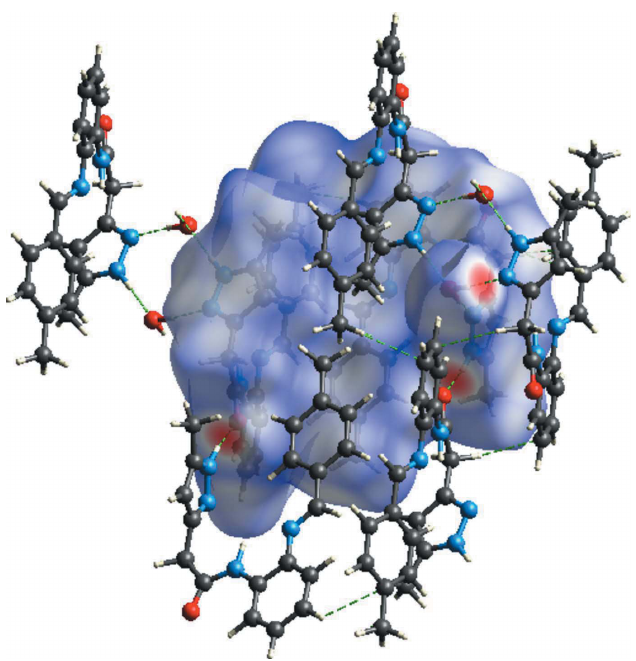
Figure 6 Hirshfeld surfaces mapped over d norm to visualize the intermolecular O— H (cid:2)(cid:2)(cid:2) N and N—H (cid:2)(cid:2)(cid:2) O hydrogen bonds and C—H (cid:2)(cid:2)(cid:2) (cid:2) interactions in the title compound. surfaces mapped over a fixed colour scale of (cid:5) 0.635 (red) to 1.583 (blue) A˚ . Fig. 6 illustrates the intermolecular O—H (cid:2) (cid:2) (cid:2) N, N—H (cid:2) (cid:2) (cid:2) O and C—H (cid:2) (cid:2) (cid:2) (cid:2) interactions (Table 1) of the title compound with d mapped on the Hirshfeld surface. norm